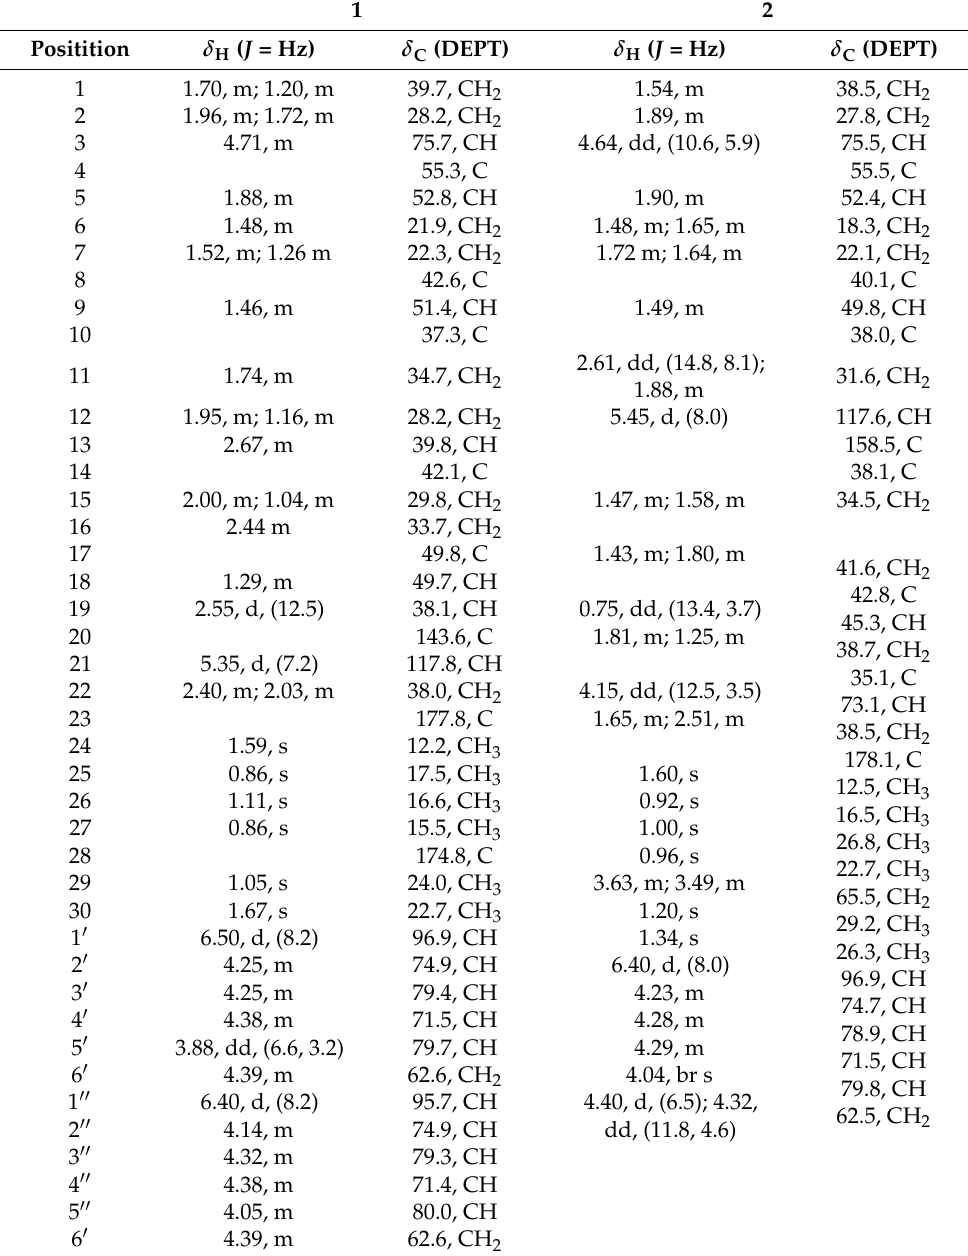
Table 1. 1 H NMR (600 MHz), 13 C NMR (150 MHz) data for Heritiera A ( 1 ) and Heritiera B ( 2 ). (in Pyridine- d 5